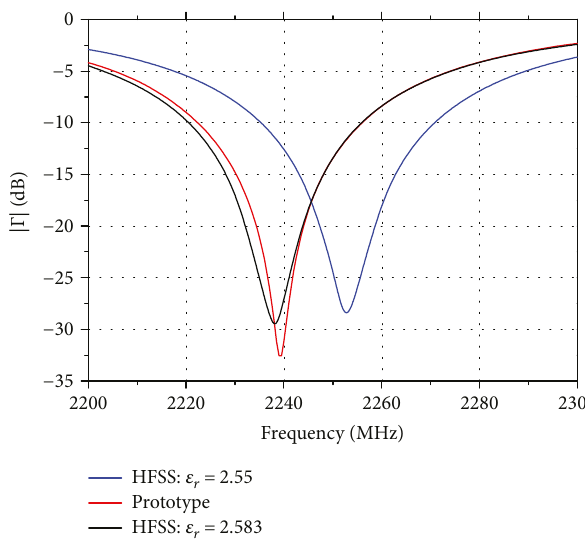
Figure 26: Re fl ection coe ffi cient module of the SIW